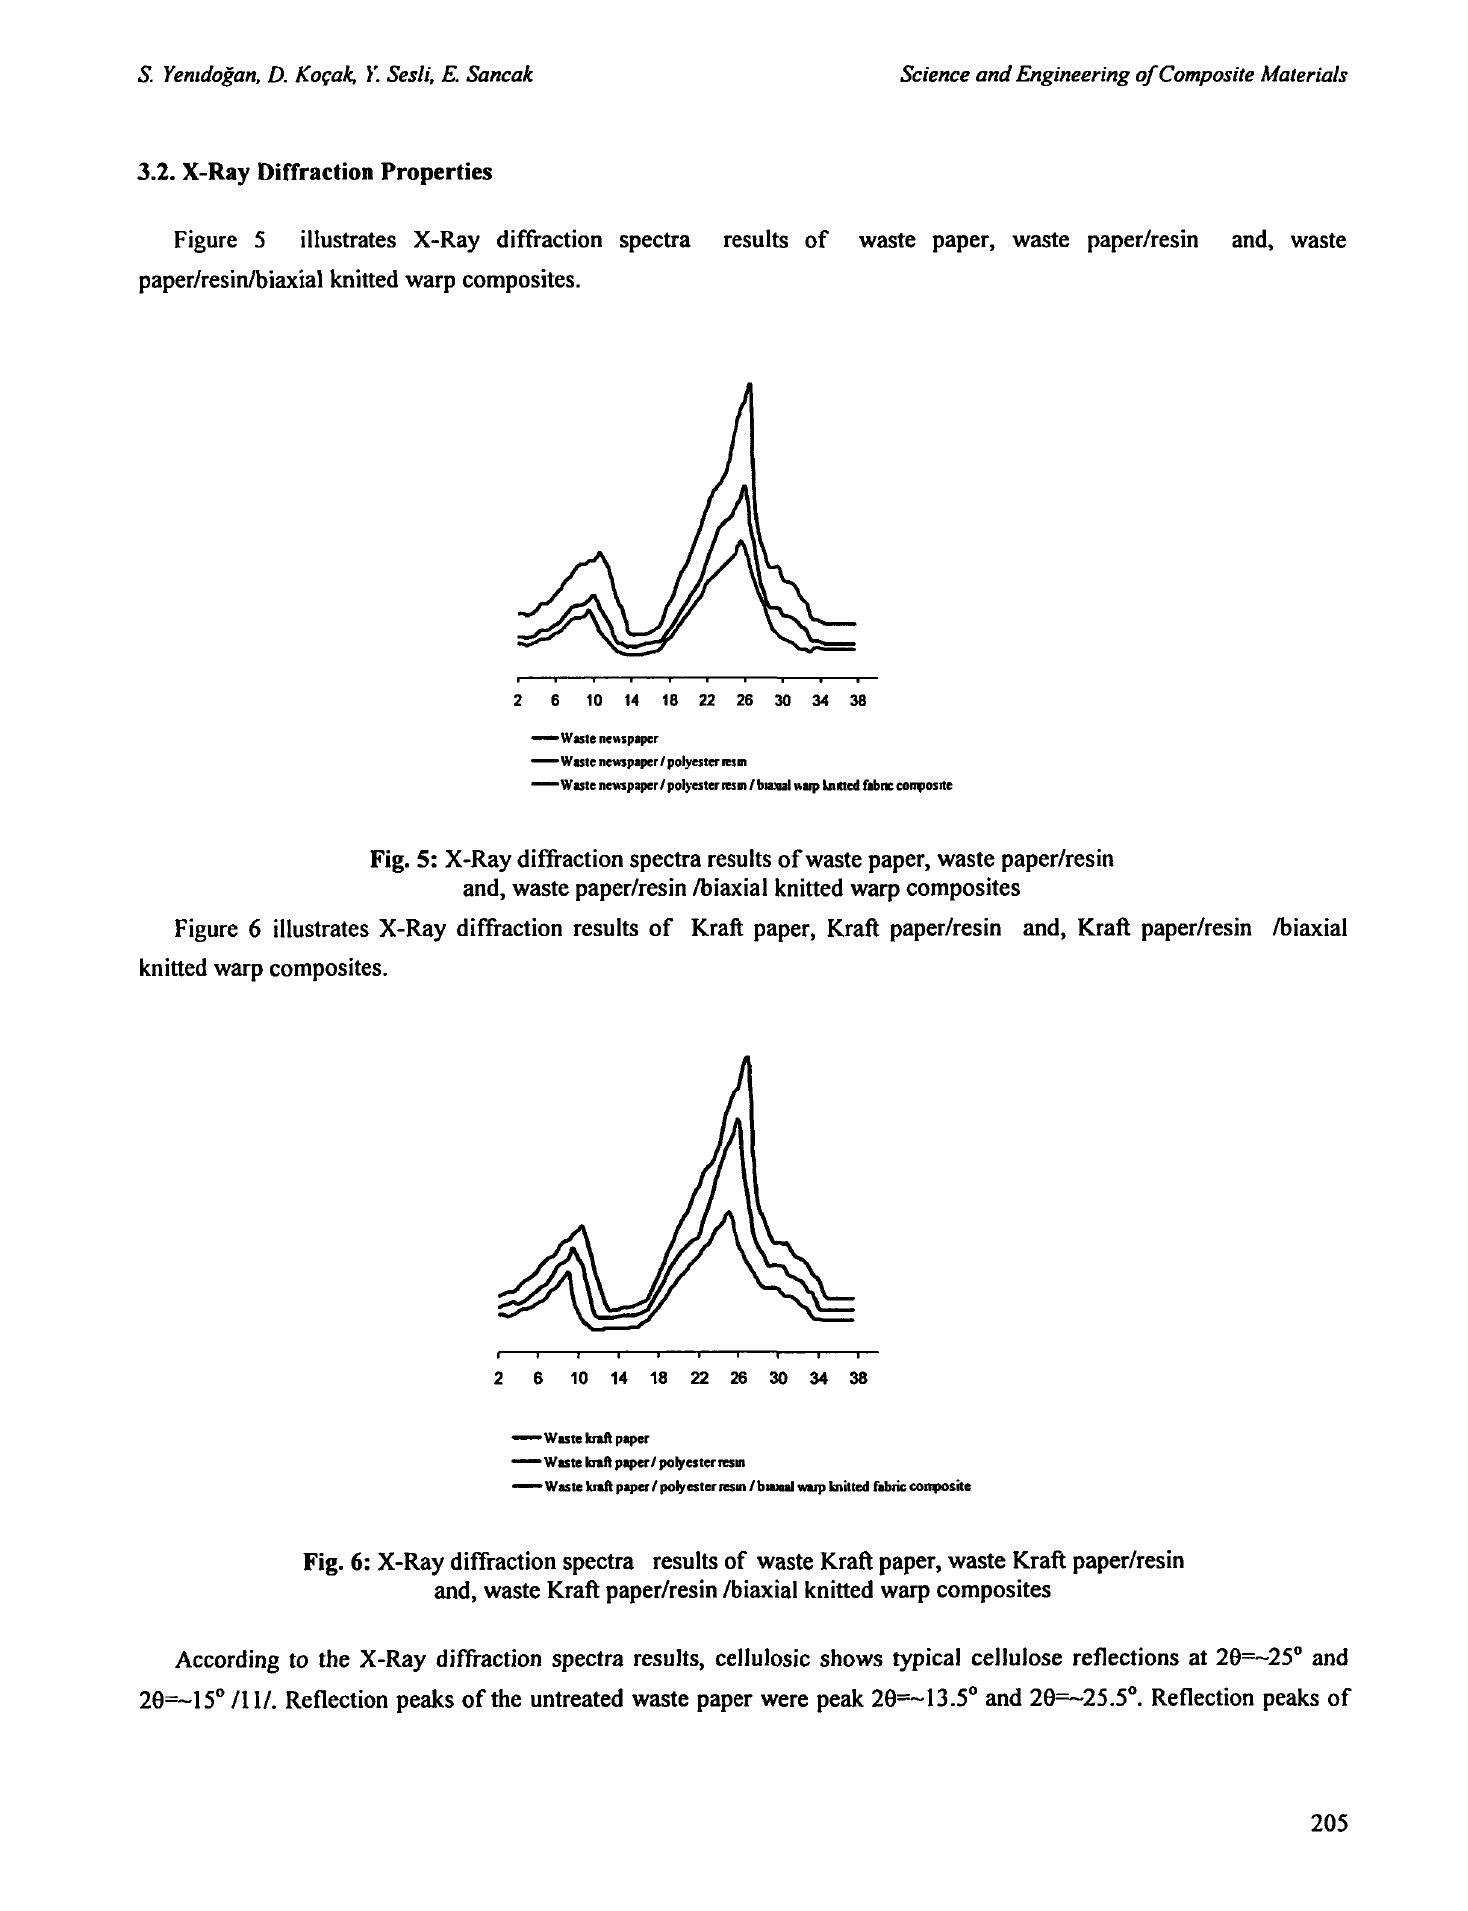
Figure 5 illustrates X-Ray diffraction spectra results of waste paper, waste paper/resin and, waste paper/resin/biaxial knitted warp composites.